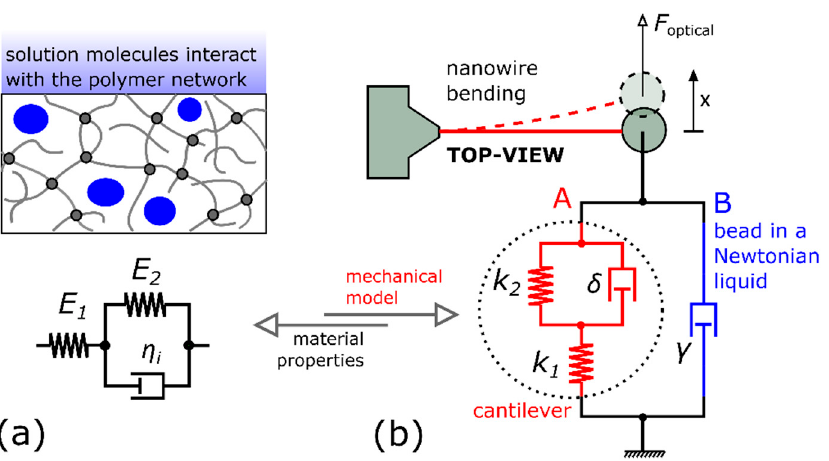
Figure 1. The scheme showing the interconnection of the used models: ( a ) the 3-parameter solid model of the photopolymer material; ( b ) the mechanical model of the cantilever system immersed in a Newtonian liquid.